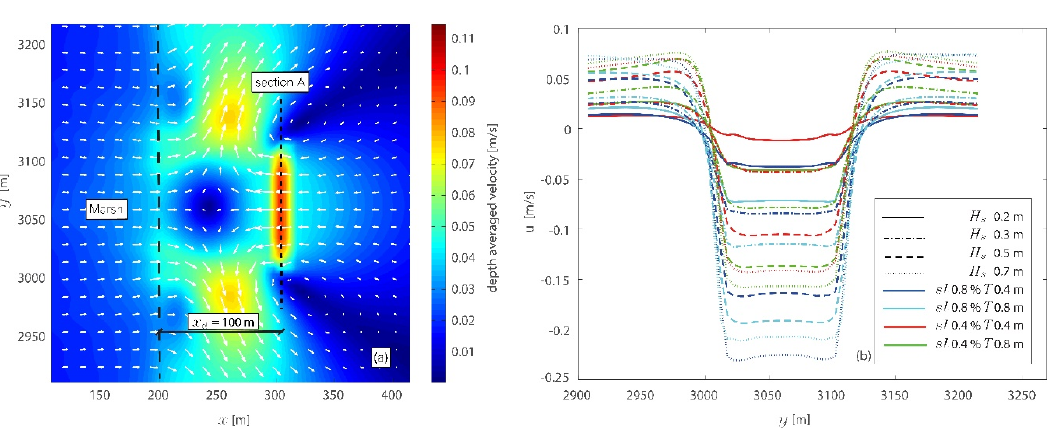
Figure 3 . ( a ) Velocity field around the breakwater related to the configuration with x d = 100 m, H s = 0.5 m and sl = 0.8 %, during the tidal flood. ( b ) U velocity component along section A related to all runs with x d = 100 m (same reading key of Plot 2a) .